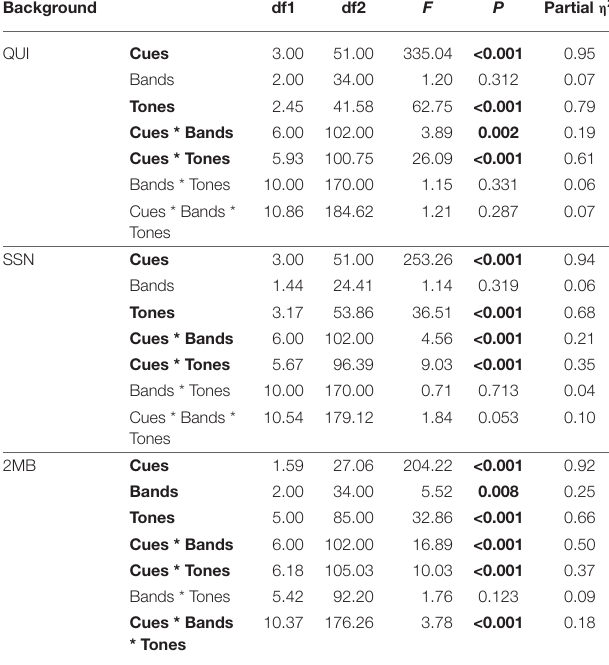
TABLE 3 | Results of Cues * Bands * Tones three-way repeated measures ANOVA on tone